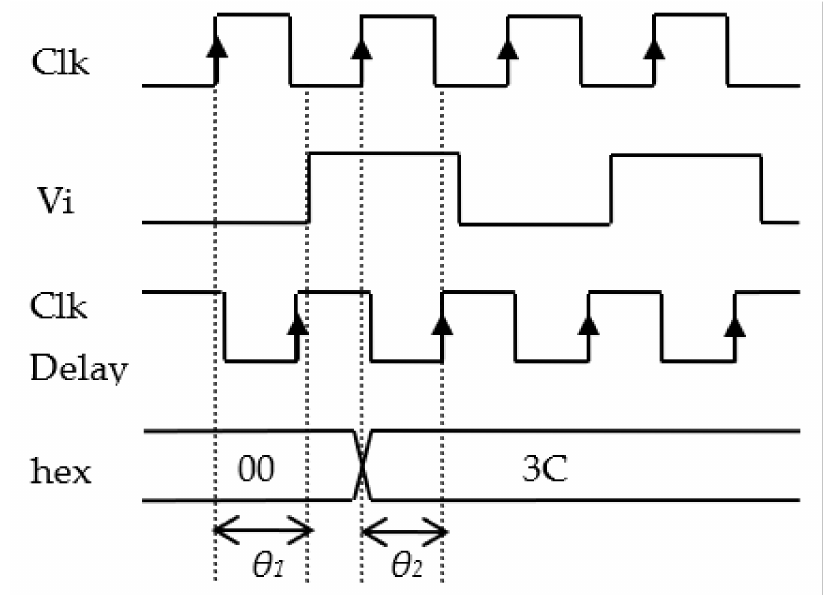
Figure 7. Timing diagram to detect the phase